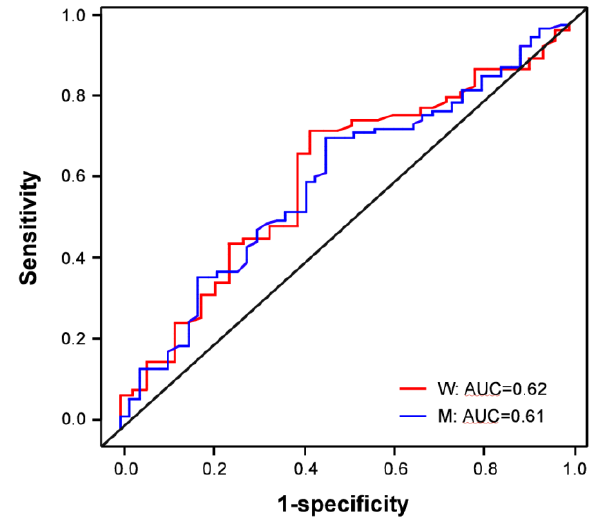
Figure 3. Receiver operating characteristic curves for log serum sHER2 concentrations of adenocarcinoma vs. squamous cell carcinoma. ROC curves for log-transformed sHER2 concentrations are shown comparing patients with adenocarcinoma vs. SCC for men (blue ROC curve labeled M) and women (red ROC curve labeled W),